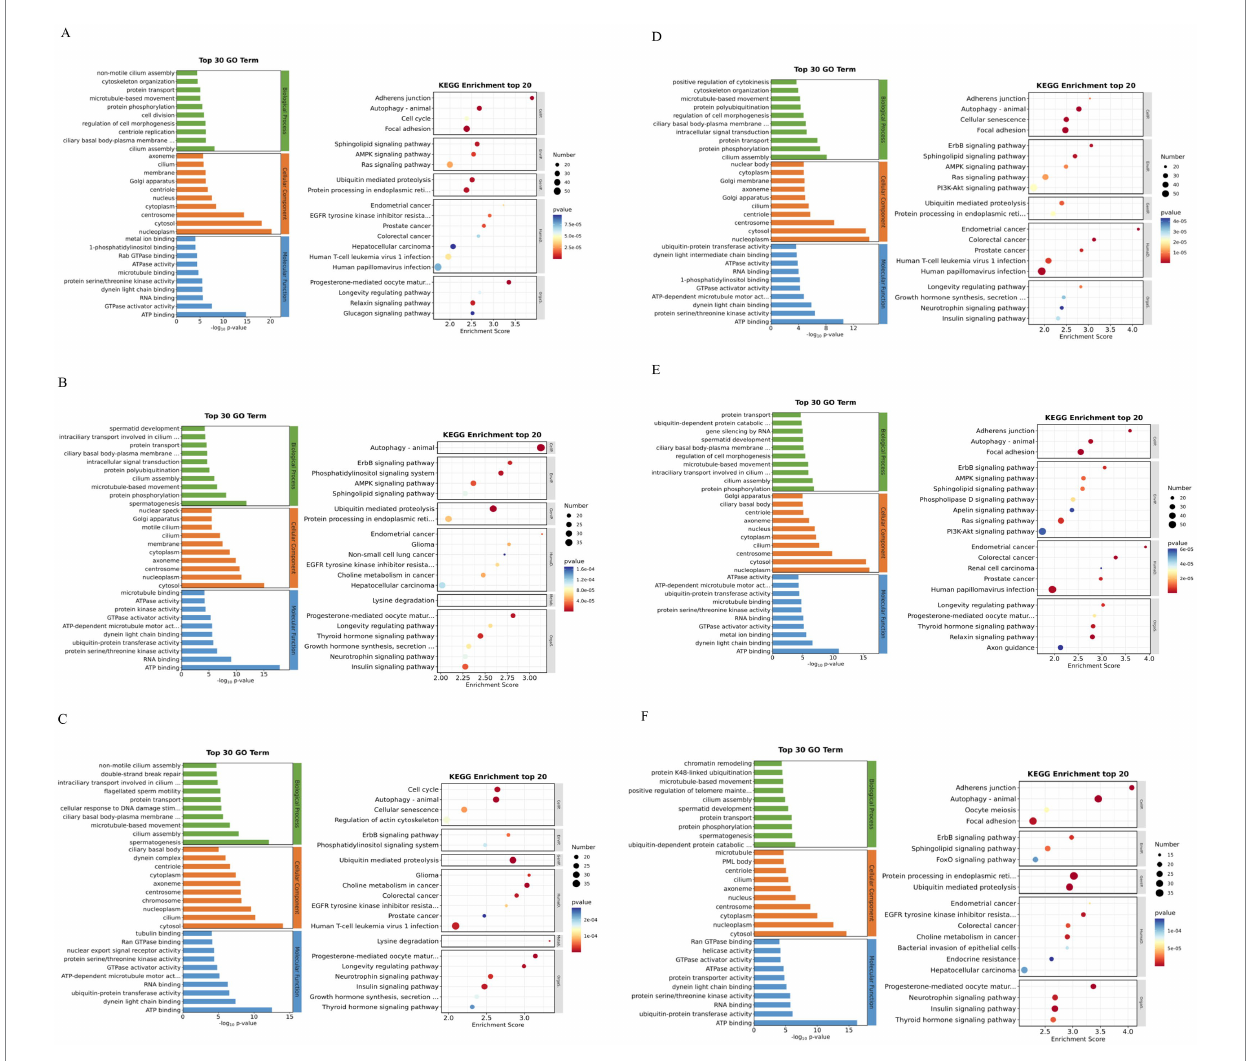
FIGURE 5 GO annotation and KEGG enrichment analysis of differential circRNA source genes in different control groups. (A) 0Y vs. 6Y, (B) 6Y vs. 12Y, (C) 12Y vs. 18Y, (D) 0Y vs. 18Y, (E) 0Y vs. 12Y, and (F) 6Y vs. 18Y; 0Y, 6Y, 12Y and 18Y refer to October, June, December and August,